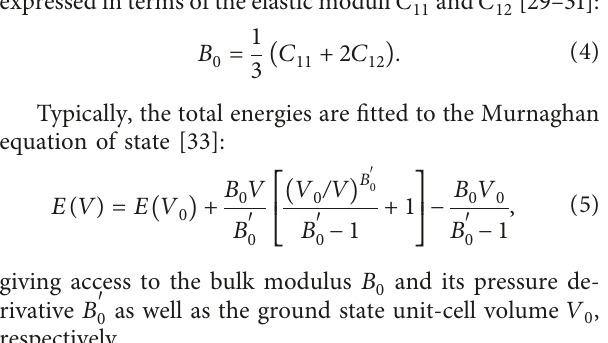
Figure 1: Crystalline phases of NaNbO 3 at room temperature and below in comparison to the cubic perovskite phase ( The rhombohedral R 3 c phase (SG 161) (a), the orthorhombic Pbcm phase (SG 57) (b), and the monoclinic Pm phase (SG 6) (c) are shown. Pictures have been generated using VESTA